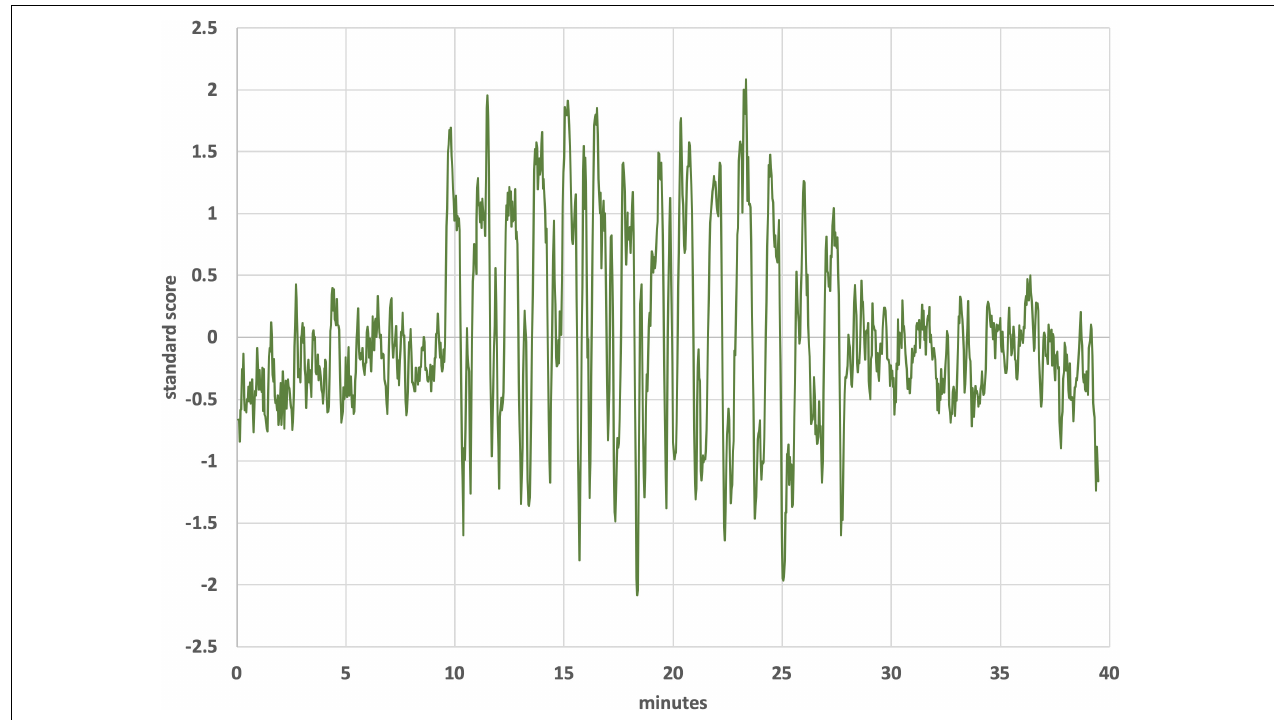
FIGURE 6 | Independent component from operculum of subject 1. The trace was smoothed by averaging each point with 4 nearest